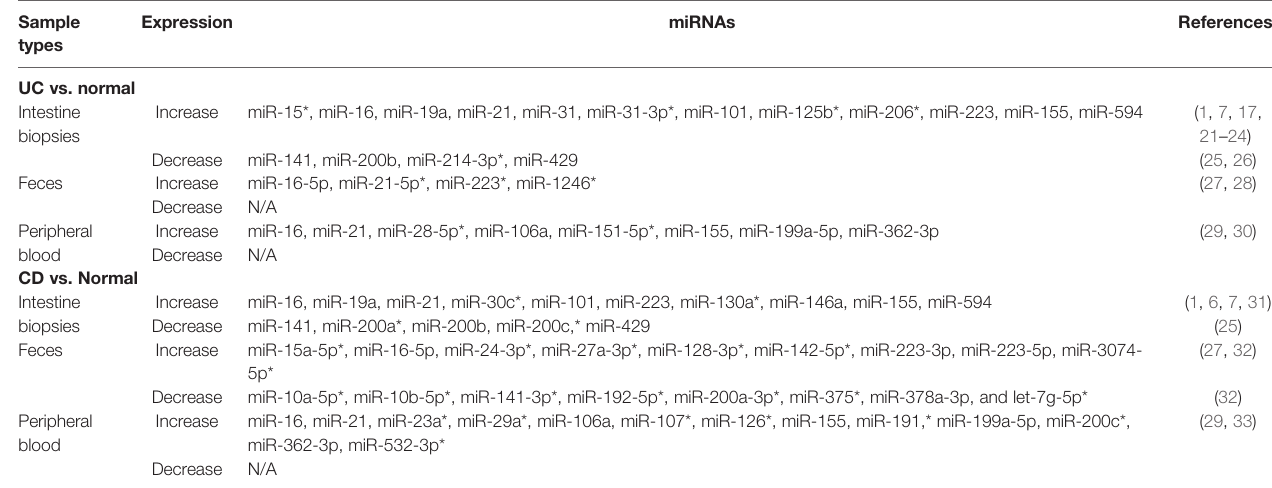
TABLE 1 | miRNA biomarkers in